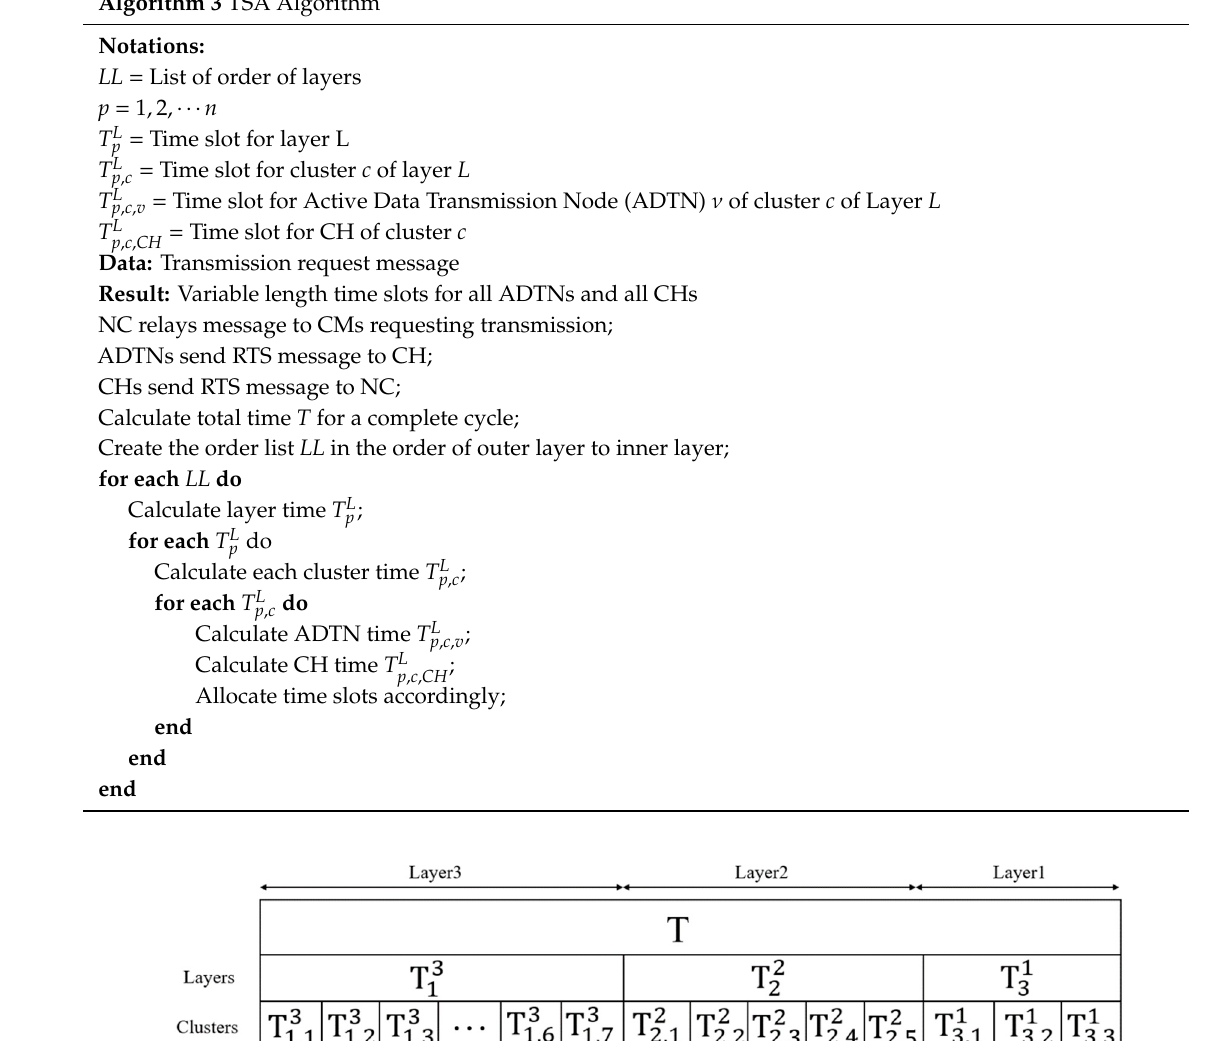
Algorithm 4: DTP (Data Transmission Process) Algorithm